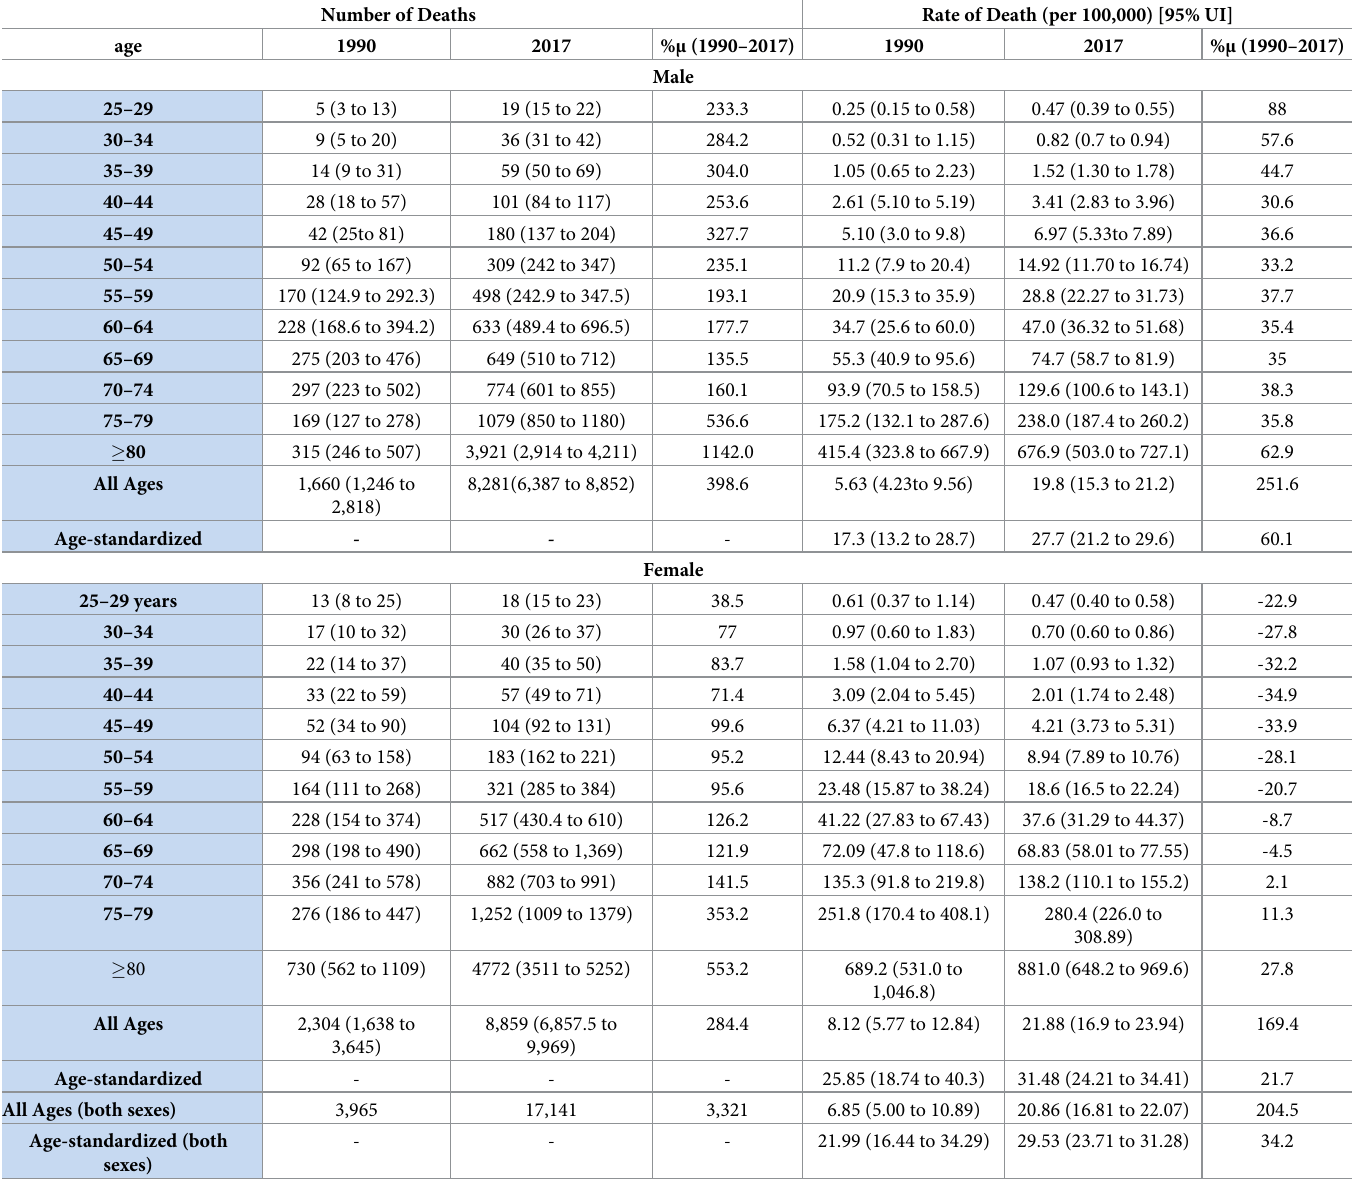
Table 2. Death number and rate of HHD by age and sex in 1990 and 2017 in